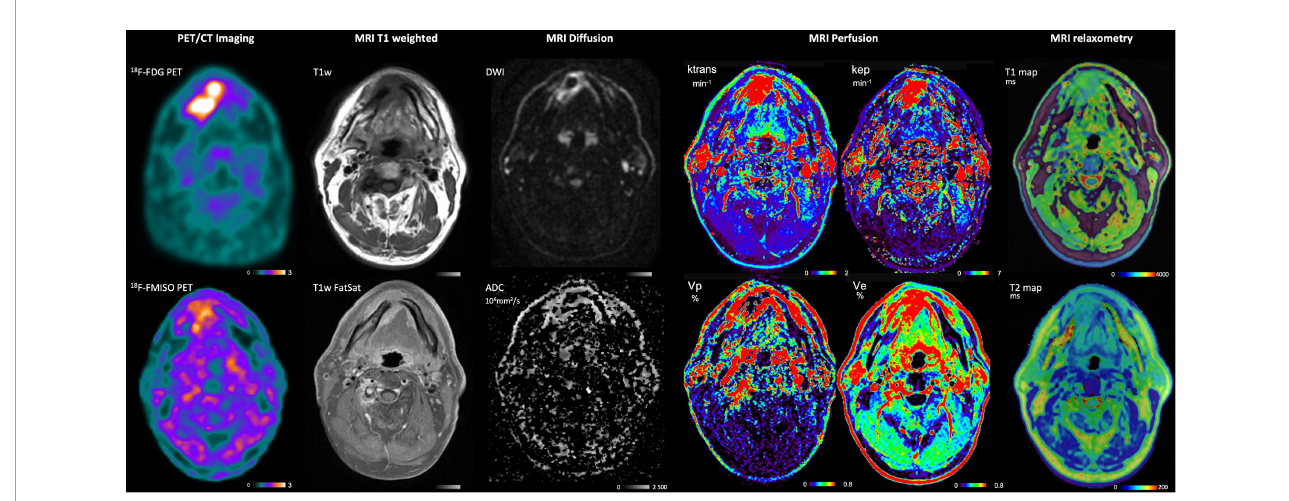
FIGURE4 PET and MRI imaging of a patient with HNC included in the study “RTEP8”. Multimodality imaging has been performed with [ 18 F]-FDG (metabolism), [ 18 F]-FMISO (hypoxia) for the PET imaging. MRI T1 weighted, MRI diffusion, MRI Perfusion and MRI relaxometry have been performed at the same time. This patient had a lesion of the right lower paramedian gum. The T1-weighted sequence showed a hyposignal infiltration and a hypersignal of the lesion with fat saturation. The lesion was in diffusion hypersignal with restriction of free water diffusion. Perfusion sequence Vp showed a contrast within the lesion proving a lack of vascularization in the tumor and might be correlated with the [ 18 F]-FMISO uptake. T1 and T2 relaxation time velocities are decreased within the